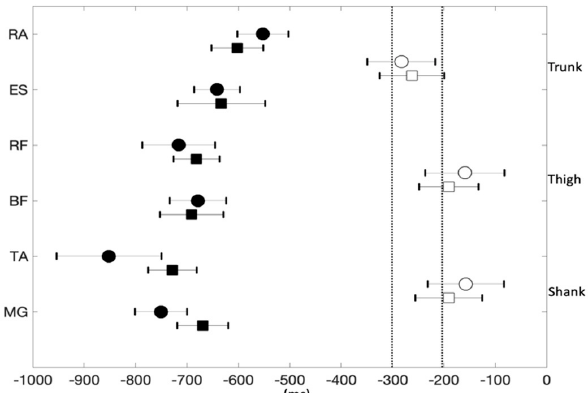
Figure 2. Onset times of muscle activation (black) for RA, ES, RF, BF, TA, and MG in the fixed condition (square) and in the sliding condition (circle). Onset times of the trunk, thigh, and shank segments movements (white) in the fixed condition (square) and in the sliding condition (circle). In addition, the dash vertical lines represent its mean ± standard error from − 300.82 ms to − 203.22 ms of the onset of the sliding board.